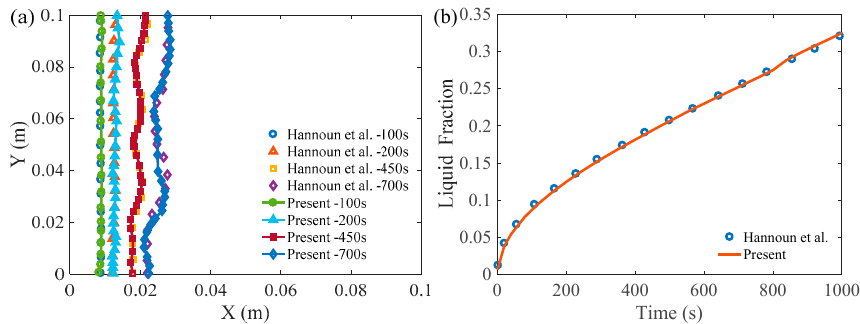
Figure 4. Numerical validation with reference [35]. ( a ) Melting front; ( b ) liquid fraction.